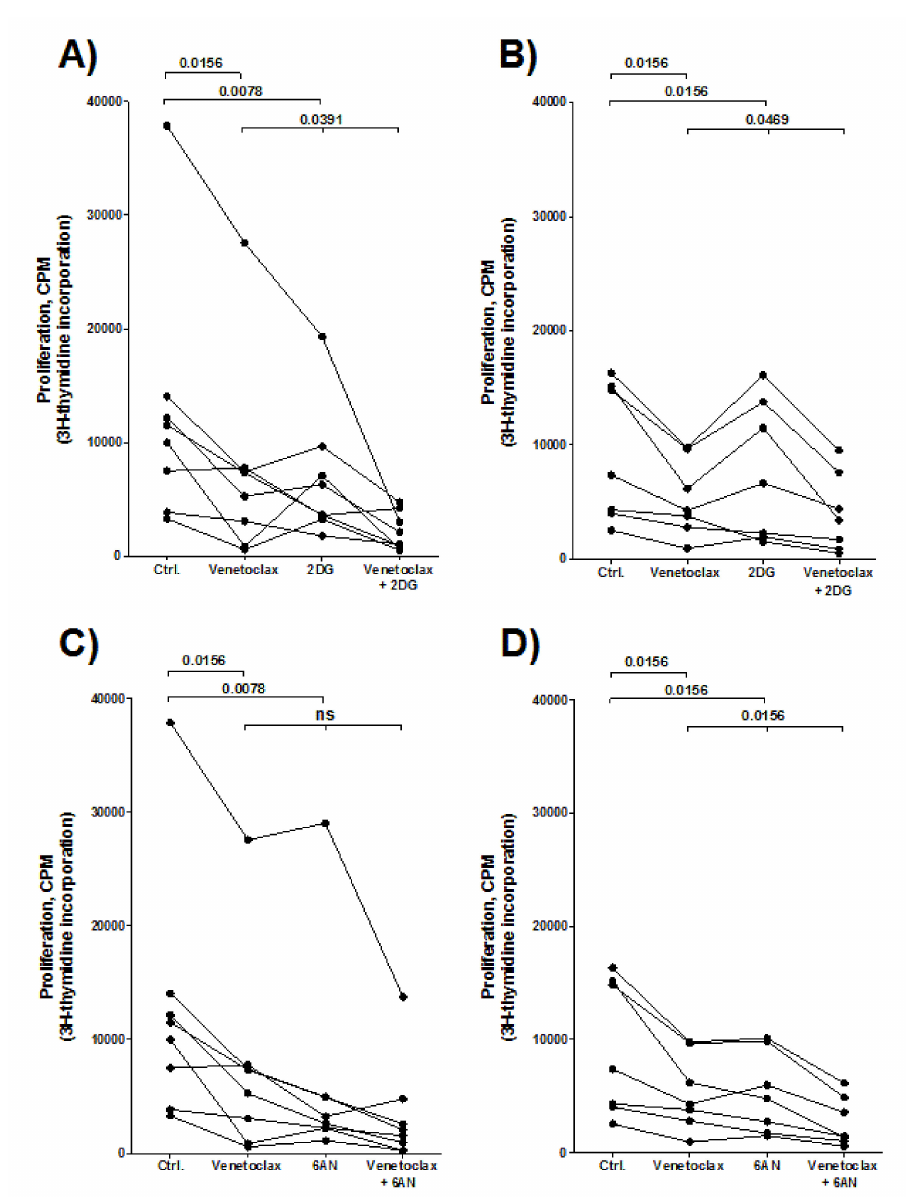
Figure 8. The e ff ect of combining venetoclax with the metabolic inhibitors 2DG or 6AN on primary AML cell proliferation. The [ 3 H]-thymidine incorporation assay was used to evaluate proliferation of primary AML cells after 7-day treatment of 50 nM venetoclax combined with either 0.3 mM 2DG ( A , B ) or 50 µ M 6AN ( C , D ). Each graph presents the cellular proliferation shown as counts per minute (cpm) for each patient sample, that is in untreated control (Ctrl.) cultures, cultures treated with venetoclax alone, cultures treated with either 2DG or 6AN alone or combination of venetoclax with 2DG or 6AN. Samples derived from sixteen AML patients were randomly chosen among the identification of two patient clusters, identified in Figure 3B, showing di ff erent sensitivity toward metabolic inhibitors, that is eight samples (shown in A , C ) from the cluster with a generally strong antiproliferative e ff ect towards metabolic inhibitors (the 29 patients in the upper cluster), while eight other samples (shown in B , D ) had a more divergent / weaker antiproliferative e ff ect towards metabolic inhibitors (lower cluster, Figure 3B). One patient sample in our analysis showed undetectable proliferation ( < 1000 cpm) and was excluded from the analysis. The p -values (Wilcoxon signed rank test) are shown for the antiproliferative e ff ects of the metabolic inhibitors combined with venetoclax compared with e ff ects observed for treatment with either the metabolic inhibitor or venetoclax alone, depending on which treatment resulted in the strongest antiproliferative e ff